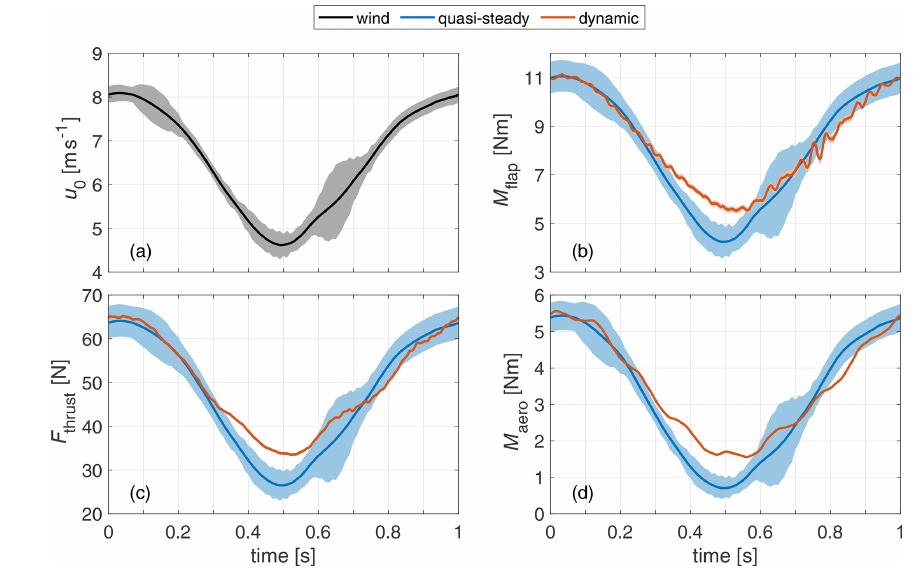
Figure 7. Sine wind field (a) and quasi-steady and dynamic experiment loads for flapwise blade root bending moment (b) , thrust (c) and aerodynamic torque (d) . The wind uncertainty shows the degree of uniformity. The uncertainty for the quasi-steady loads accounts for this non-uniformity and the uncertainty in the aerodynamic characterisation. The dynamic loads are shown along the 95%